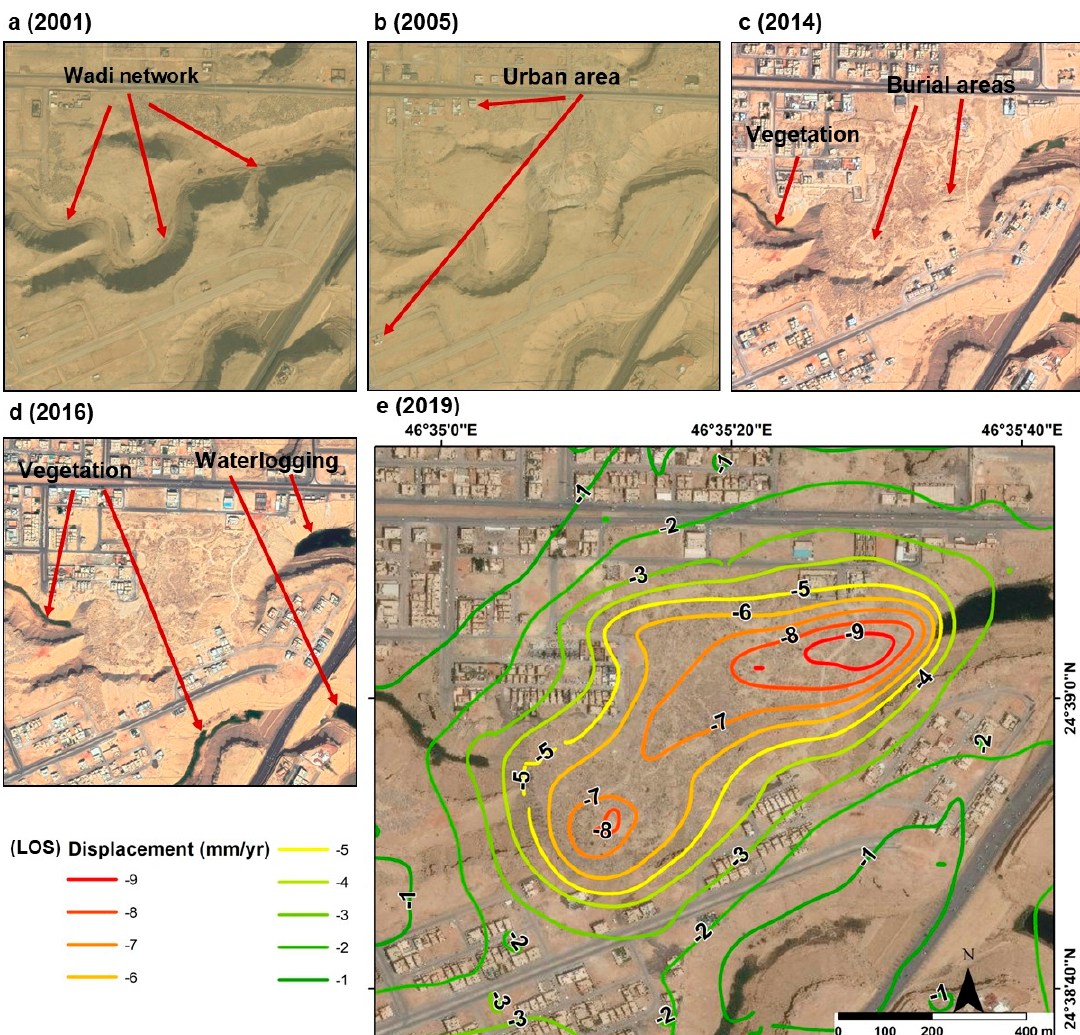
Figure 7. Temporal Google Earth images (2001 to 2016), ArcGIS online base map (2019), and LOS velocities over a wadi (site W5 in Wadi Hanifah). ( a ) Google Earth image acquired in March 2001. ( b ) Google Earth image acquired in February 2005. ( c ) Google Earth image acquired in November 2014. ( d ) Google Earth image acquired in October 2016. ( e ) LOS deformation rates plotted over the 2019 ArcGIS online base map.